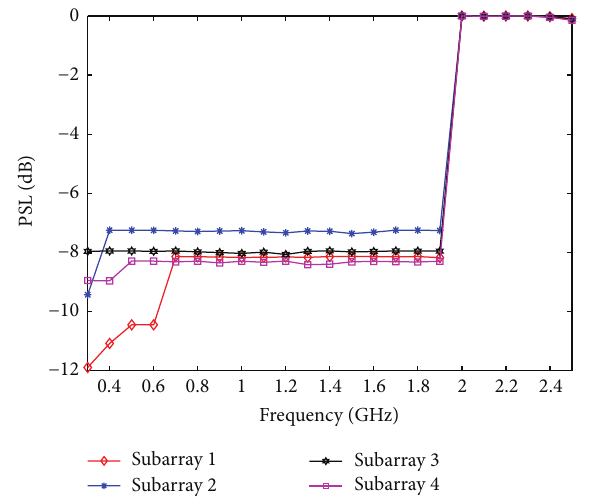
Figure 5: The curve of the relation between the carrier frequency and